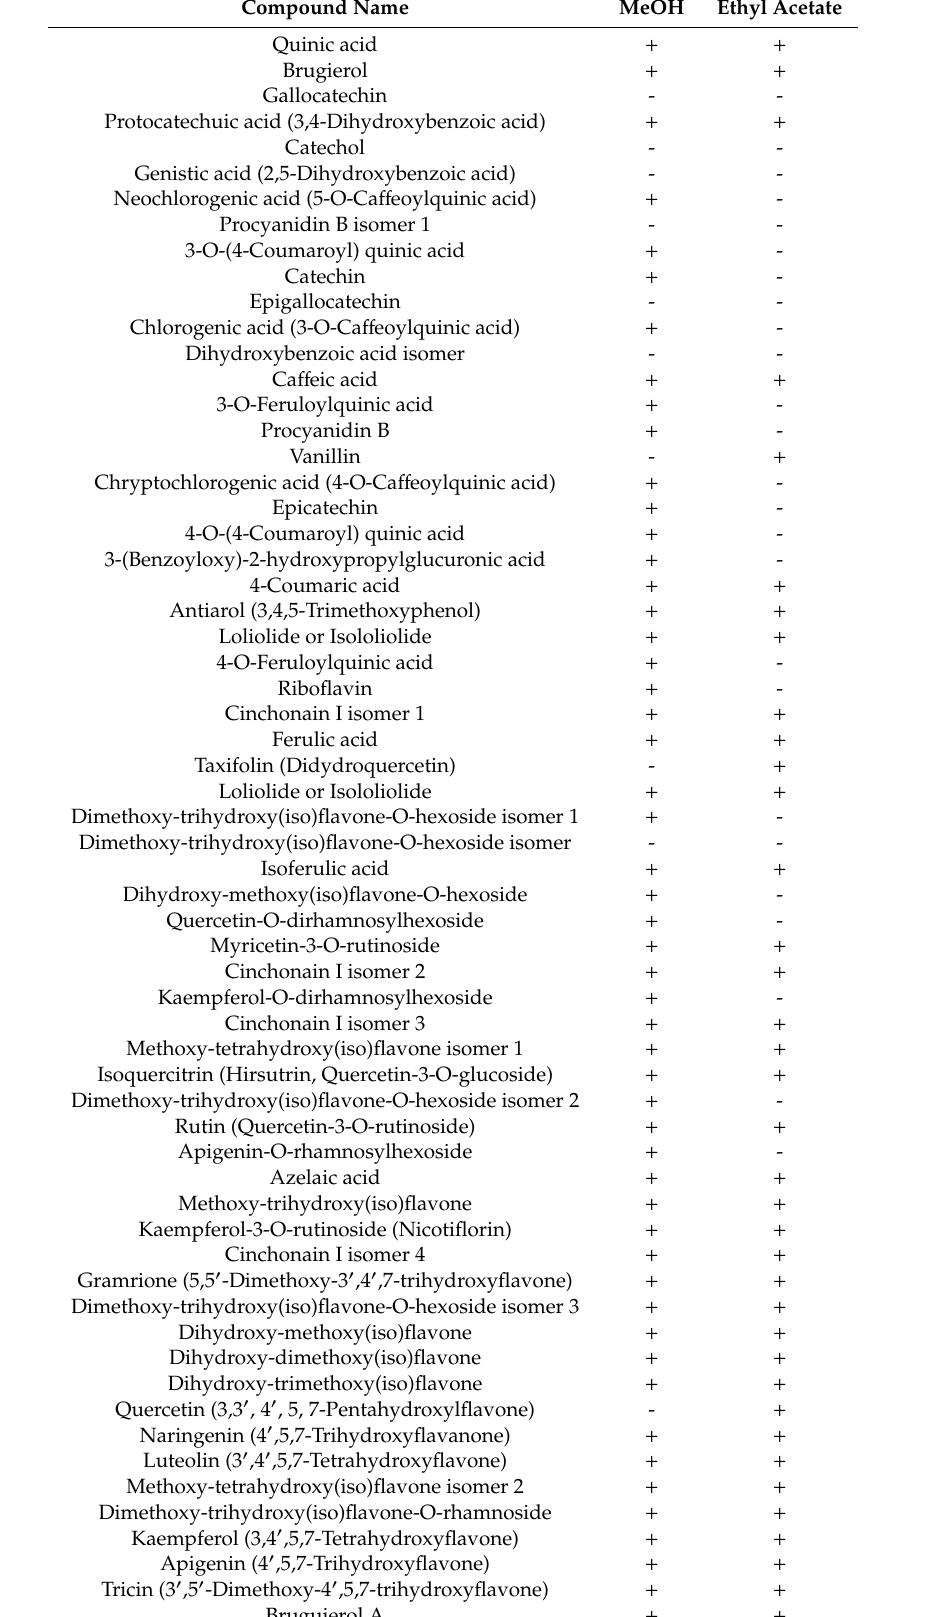
Table 2. Chemical composition of leaf